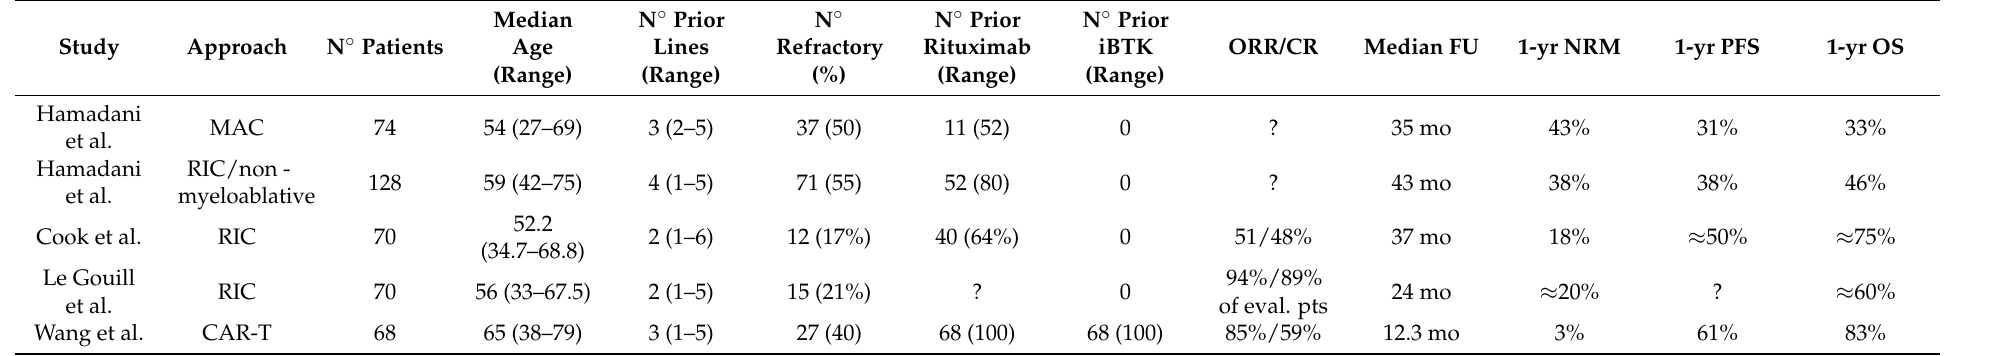
Table 3. Comparison between CAR-T KTE-X19 therapy and